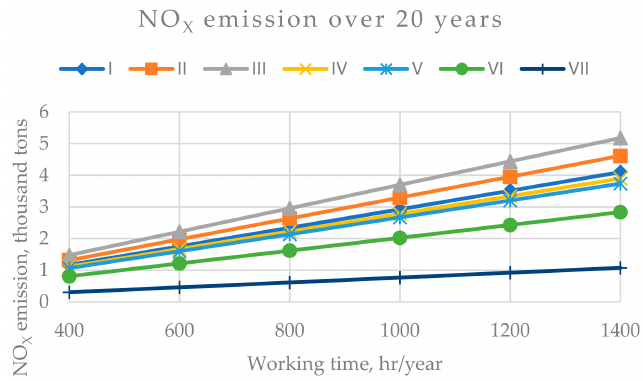
Figure 5. NO X emission of individual heating systems for an operating time of 400 to 1400 h over 20 years of use, where: I—electric heating power supply, II—liquid heating supplied from the district heating network, III—liquid heating powered by a hard coal boiler, IV—liquid heating powered by a biomass boiler, V—liquid heating with fuel oil boiler, VI—liquid heating powered by a natural